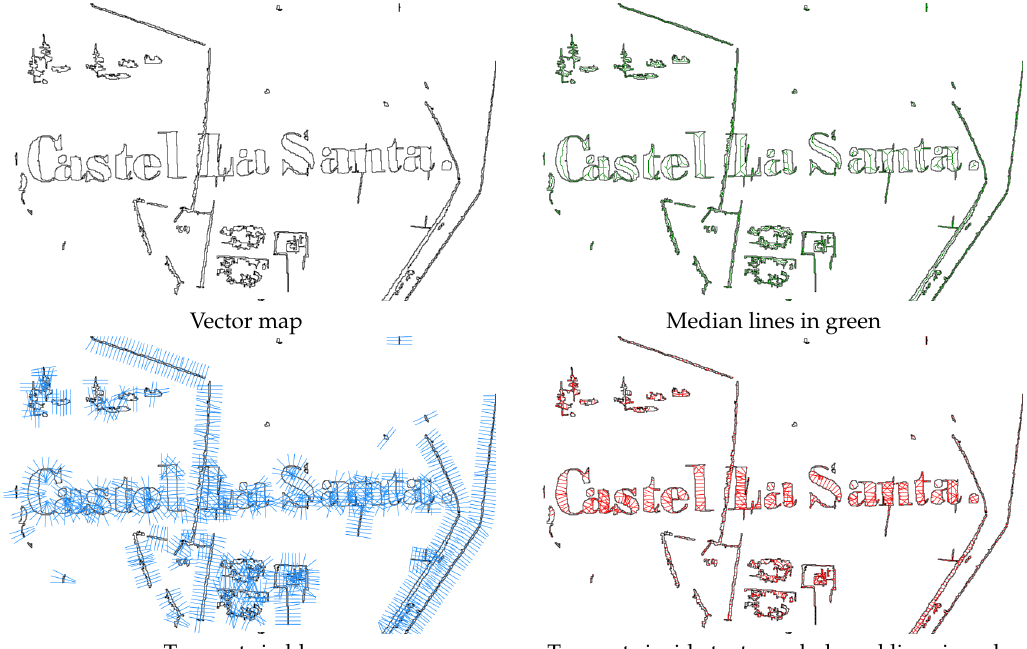
Figure 15. Procedure for the evaluation of the minimum filter size to remove all the text, symbols and lines: original vector map, median lines, transects and transects inside text, symbols and lines’